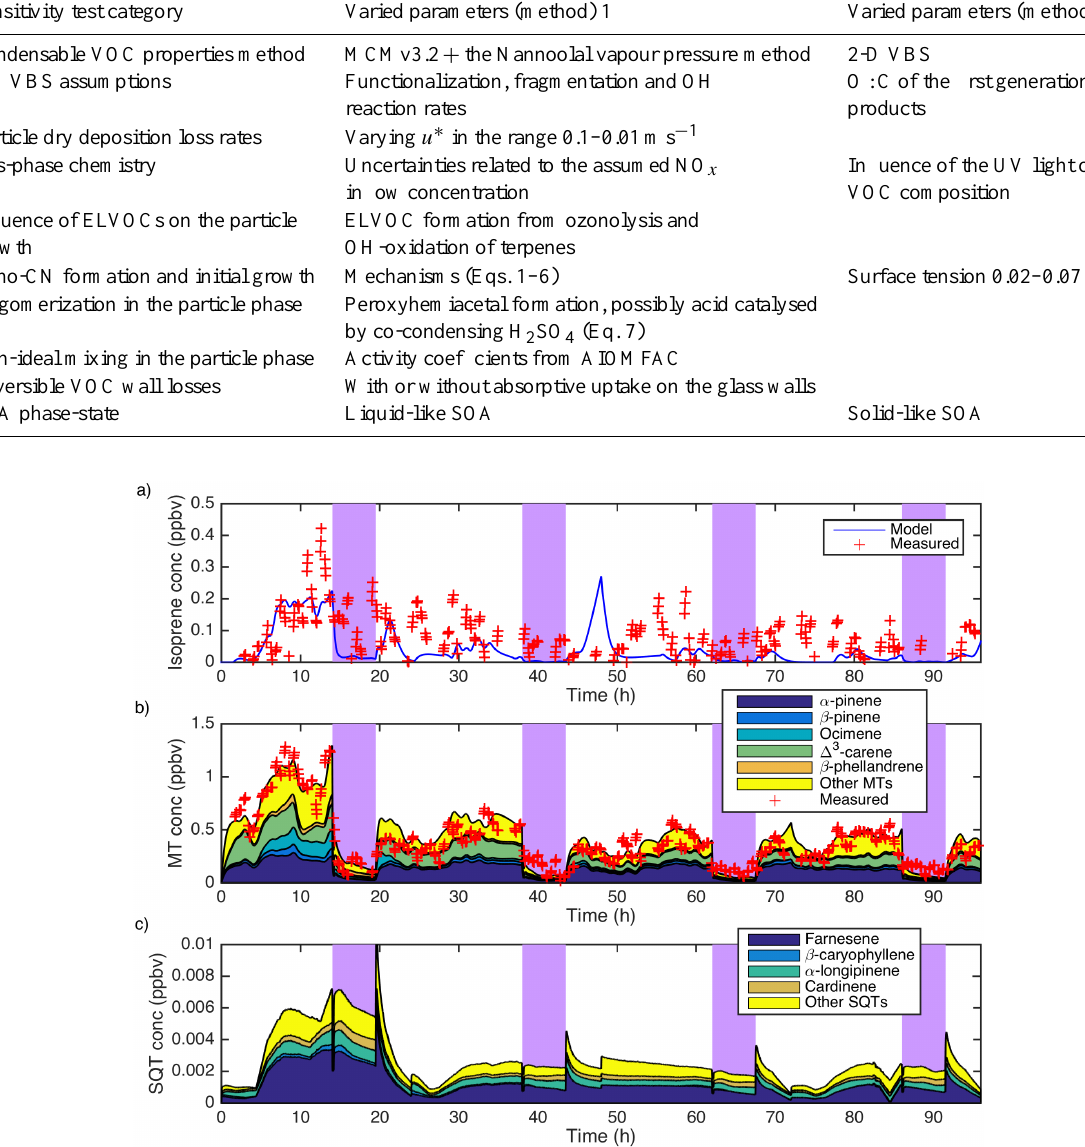
Figure 5. Modelled isoprene (a) , monoterpene (b) , and sesquiterpene (c) concentrations together with the measured isoprene and monoter- pene concentrations in the JPAC reaction chamber. In (b) we left out those monoterpenes that had a negligible contribution to the total monoterpene concentration. The purple bars indicate UV on periods during the